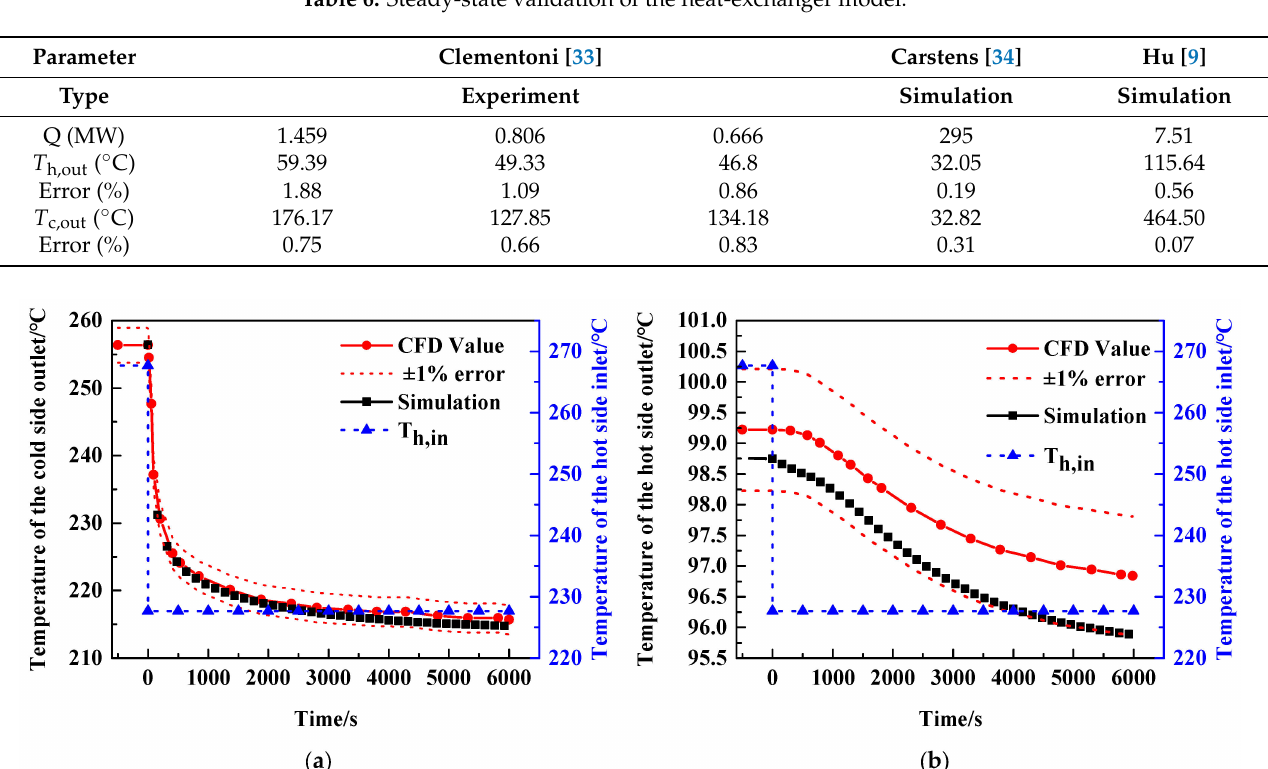
Table 6. Steady-state validation of the heat-exchanger model.